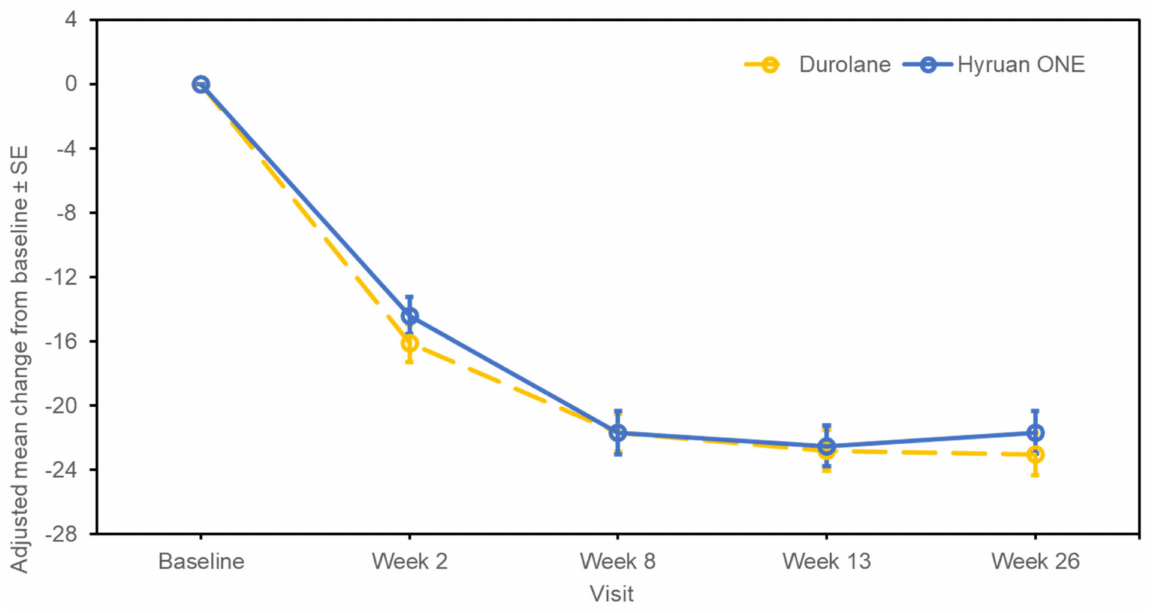
Figure 3. Western Ontario and McMaster Universities–Likert Total score changes from baseline to post-injection (per-protocol set). SE, standard error.